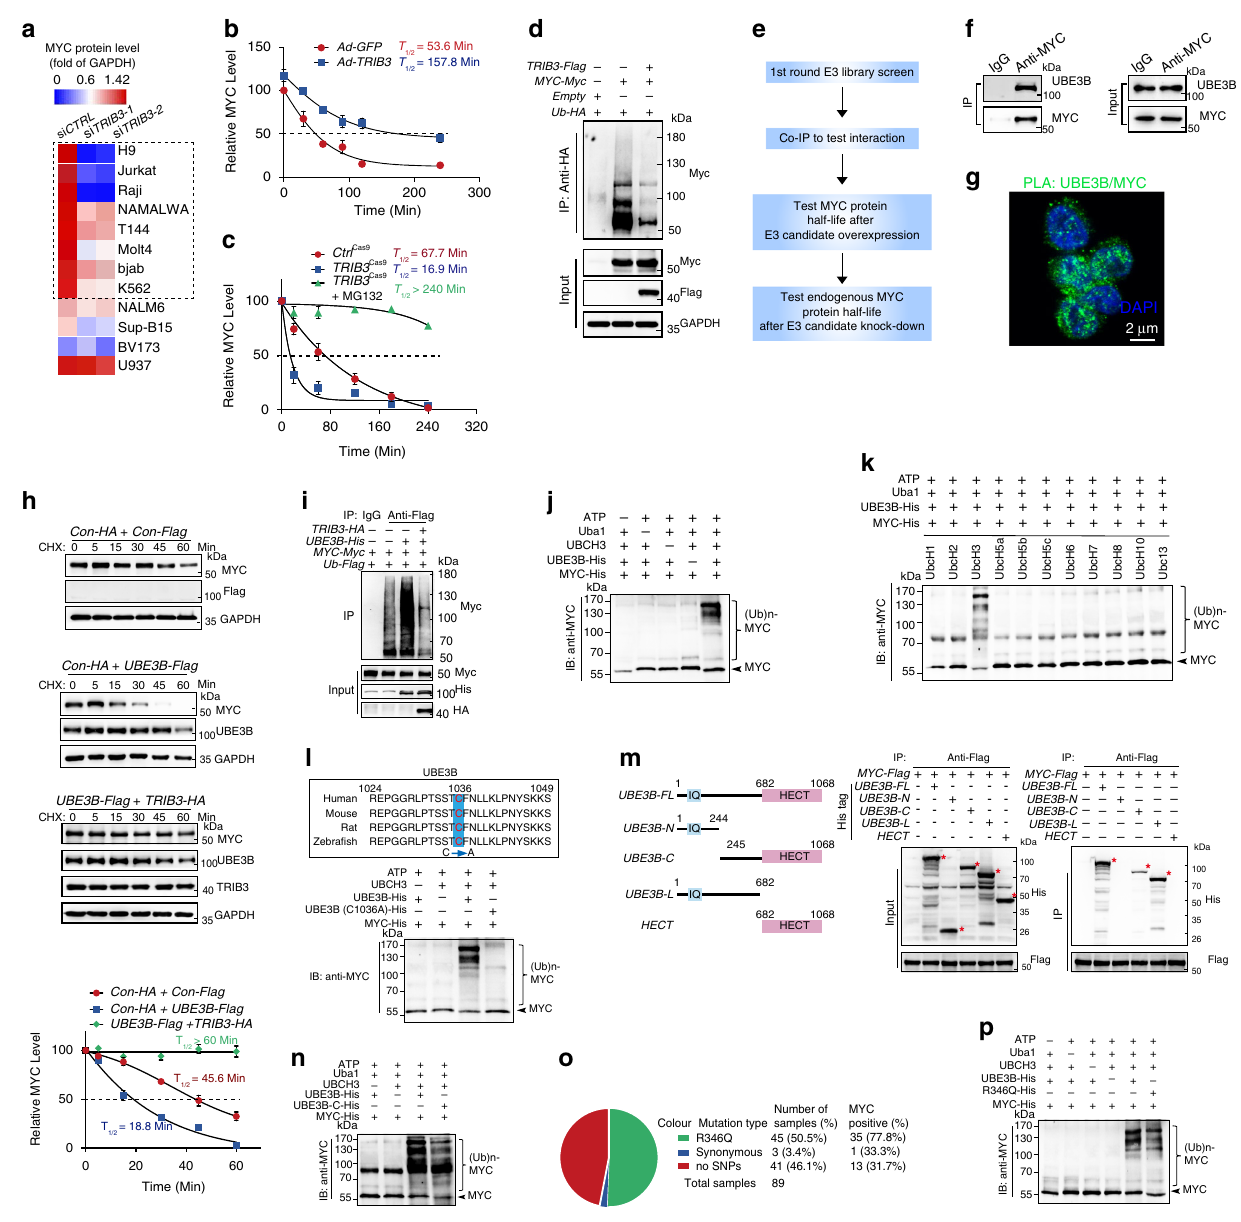
stability 36 – 40 . We used phospho-speci fi c antibodies to accurately quantify the level of Phospho-T58 (P-T58) and Phospho-S62 (P- S62) relative to total MYC in TRIB3 depleted cells. Upon TRIB3 knockdown in Jurkat and Raji cells, we observed a decrease in the P-S62 signal, but no change in the P-T58 signal (Supplementary Fig. 2k, l). Quantifying the ratio of P-T58 to total MYC revealed a substantial increase in the amount of T58 phosphorylated MYC with TRIB3 knockdown (Supplementary Fig. 2k, l). In addition, the signal for P-S62 relative to total MYC decreased in TRIB3 depleted cells compared with control group (Supplementary Fig. 2k, l). Similarly, TRIB3 overexpression increased S62 and decreased T58 phosphorylation relative to total MYC level in Raji cells (Supplementary Fig. 2m). Furthermore, the analysis of half- life of endogenous MYC protein revealed that TRIB3 deletion reduced the stability of MYC protein, especially accelerated P-T58 MYC protein degradation after cycloheximide treatment,